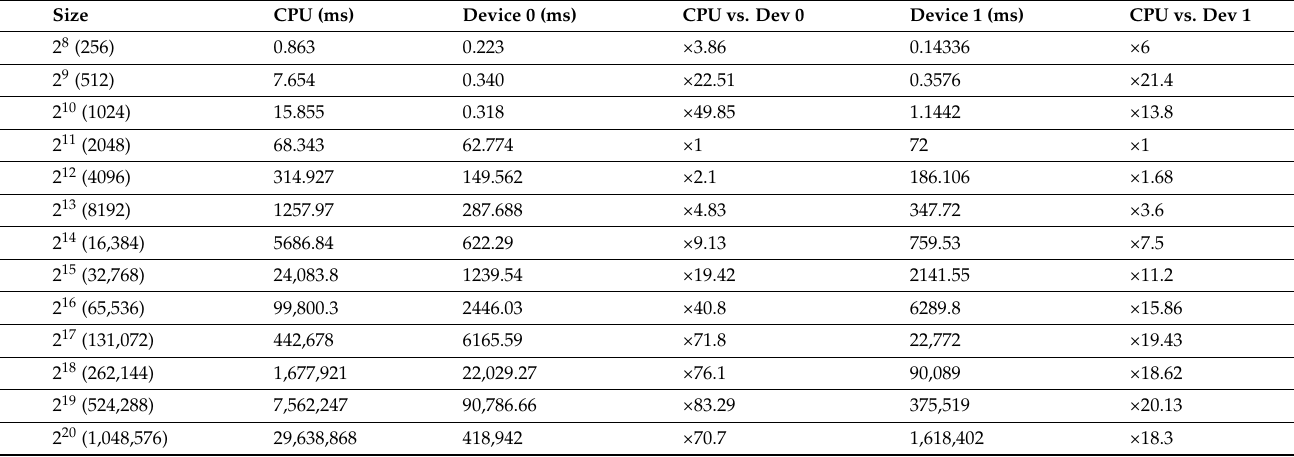
Table 2. Computing